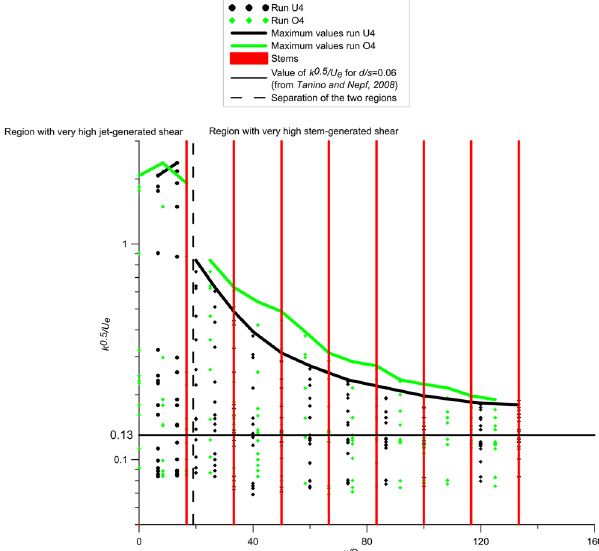
Figure 5. Values of k 0.5 / Ue with the definition of the region with very high jet-generated turbulence (on the left) and the region with very high-stem generated turbulence (on the right). The figure shows also the expected value of k 0.5 / Ue for d/s = 0.06 for obstructed channel flow (from Tanino and Nepf 30